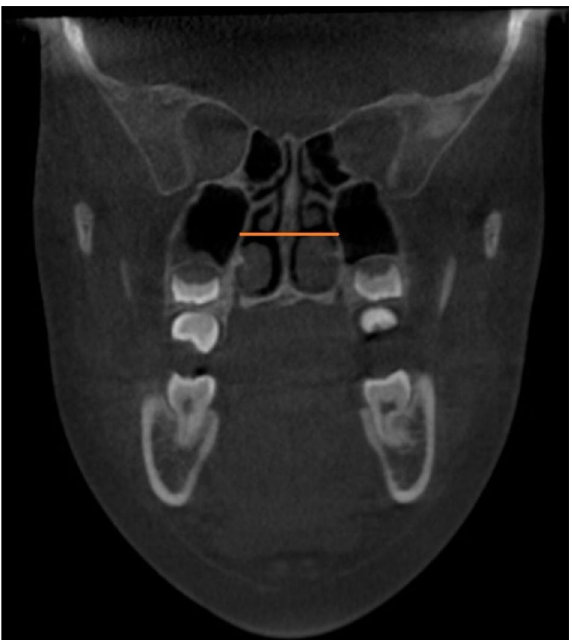
Figure 3. Measurement of the linear distance between the lateral walls of the nasal cavity (NCd), coronal view.